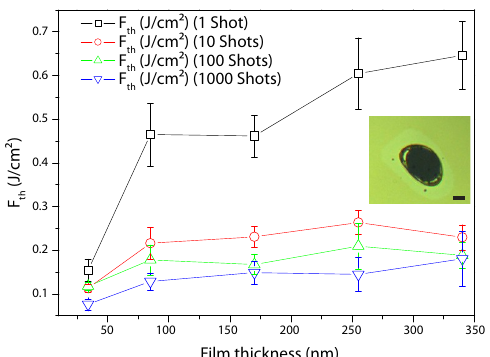
Figure 7: Laser-induced damage thresholds of solid gold layers in dependence of layer thickness and for exposure to different num- bers of 30fs pulses. The inset shows a typical damage site on the 80nm sample. The scale bar is 10 µm .